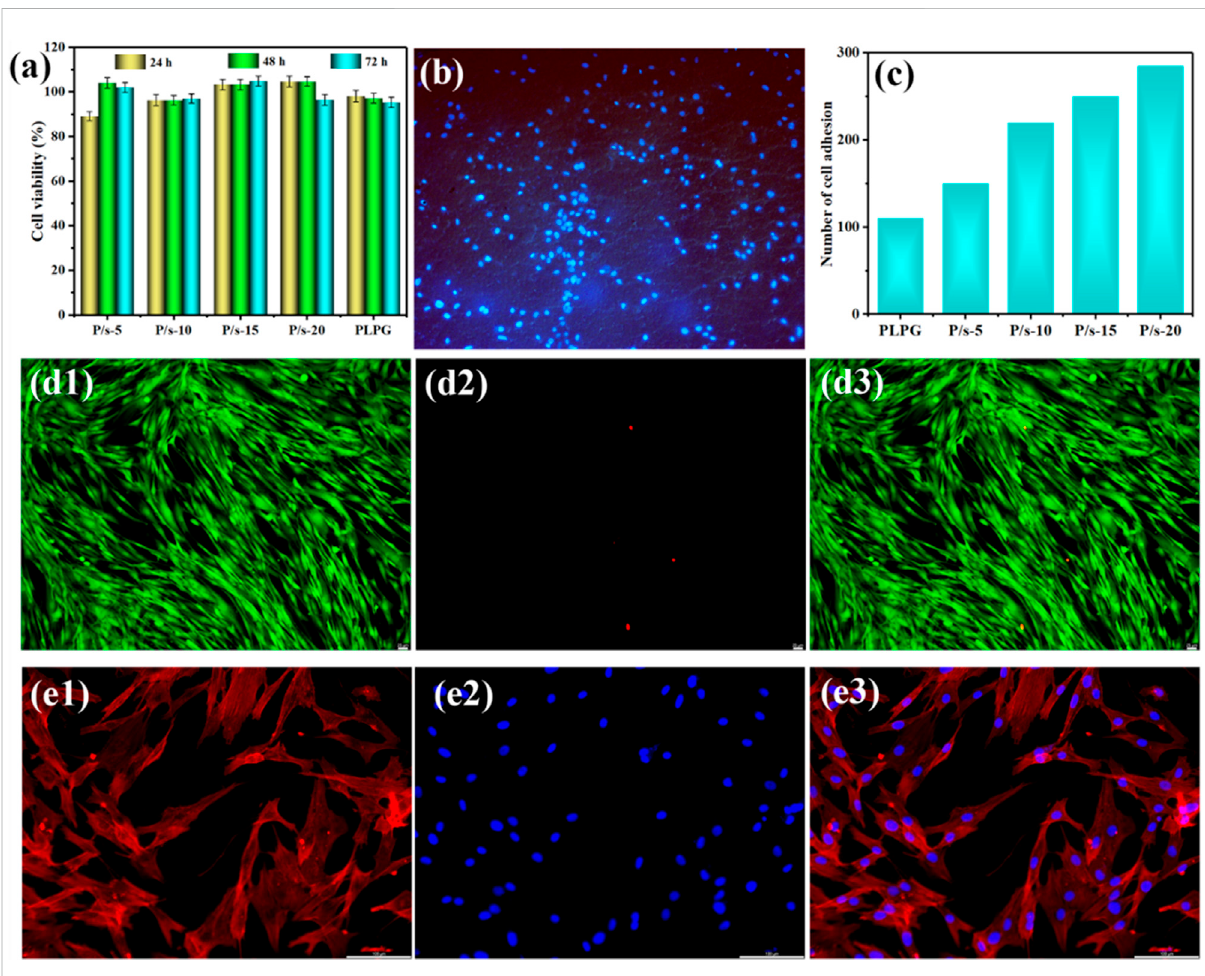
FIGURE 6 (A) CCK-8 assay of hADSCs for 24, 48, and 72 h, (B) cell adhesion on the surface of P/s-10 for 4 h ( × 10), (C) number of cell adhesions on the surface of the samples for 4 h, (d1 – d3) live/dead cell viability of the P/s-10 blends for 48 h ( × 20), and (e1 – e3) representative immuno fl uorescence microscopy images of the P/s-10 blends for 48 h ( ×